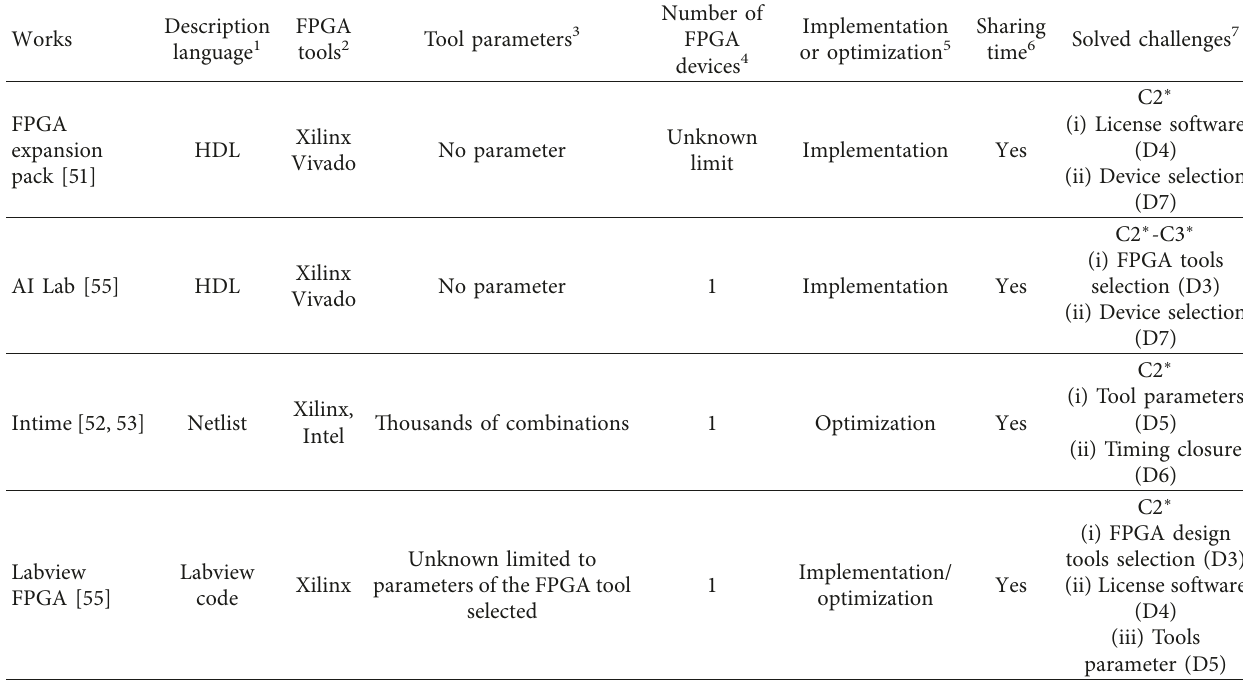
Table 3: Summary of FPGA software tools as a